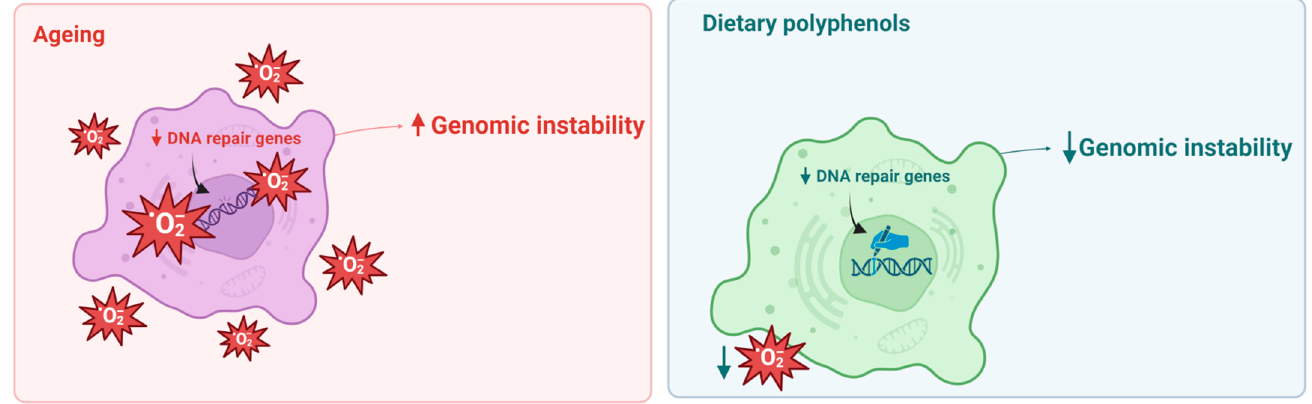
Figure 2. Genome instability is an important hallmark of ageing ( left panel). Dietary polyphenols can decrease genomic instability through the regulation of ROS levels and increase DNA repair activity ( right panel).